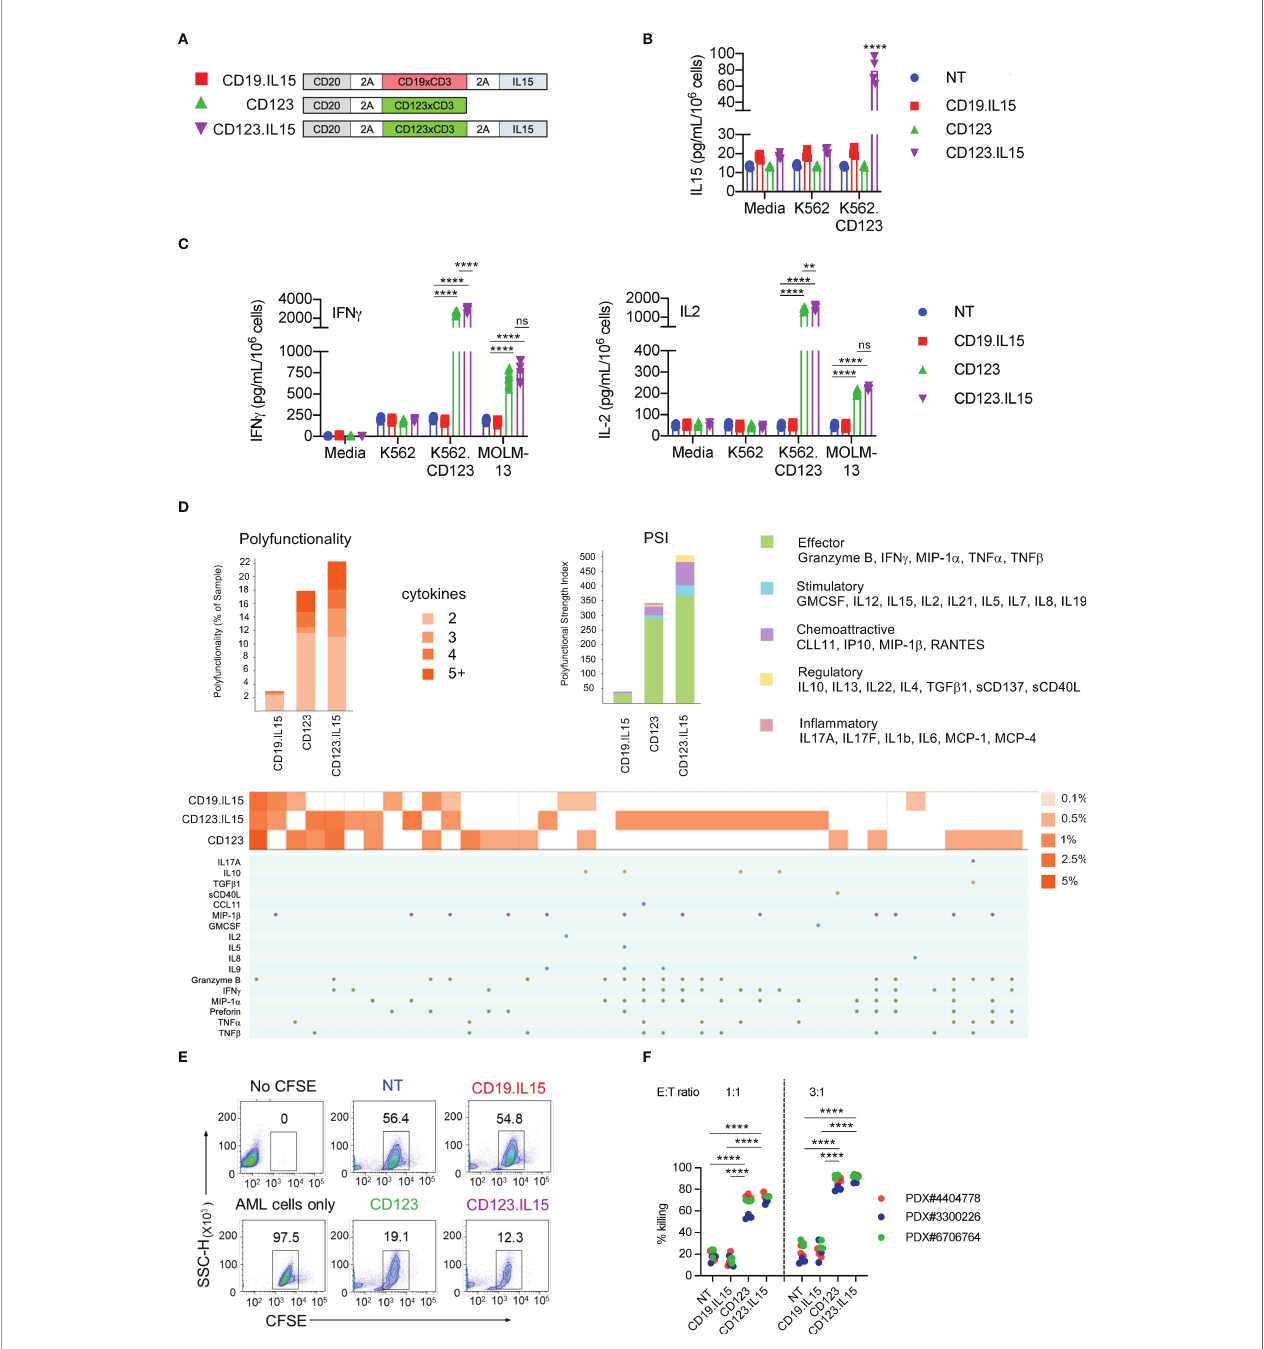
FIGURE 1 | Characterization of CD123-ENG T-cells expressing IL15. (A) Schematic of retroviral vector constructs encoding CD123-ENG.IL15, CD123-ENG, and CD19- ENG.IL15. (B) IL15 concentration (pg/ml/10 6 cells) determined by ELISA at baseline and after co-culture for 24 h with K562.CD123 or K562 at an E:T ratio of 2:1; n = 4; technical duplicates; for K562.CD123: NT, CD19.IL15, or CD123 vs CD123.IL15: ****:p <0.0001; two-way ANOVA. (C) IFN g and IL2 concentration (pg/ml/10 6 cells) determined by ELISA at baseline and after co-culture for 24 h with indicated target cells or media at an E:T ratio of 2:1; n = 4; technical duplicates; ****: p <0.0001; **: p <0.01; ns, not signi fi cant; two-way ANOVA. (D) CD123-ENG.IL15, CD123-ENG or CD19-ENG.IL15 T-cells were stimulated with MOLM-13 AML cells and after 20 h subjected to single-cell multiplex cytokine analysis. Left panel: T-cell polyfunctionality is shown by the percentage of each subset of polyfunctional T cells in total based on the number of cytokines. Right panel: Polyfunctional Strength Index (PSI) generated using IsoSpeak software based on cytokine strength in different categories and T cell polyfunctionality. Bottom panel: The percentage of polyfunctional T cell subsets with distinct combinatorial cytokine secretions are shown in heat map and cytokine panel. (E, F) Flow cytometry-based cytotoxicity assay with primary AML blast at an E:T ratio of 3:1 for 6h. (E) Representative fl ow cytometry plots for AML PDX#3300226. (F) Summary data, ****: p <0.0001, two-way